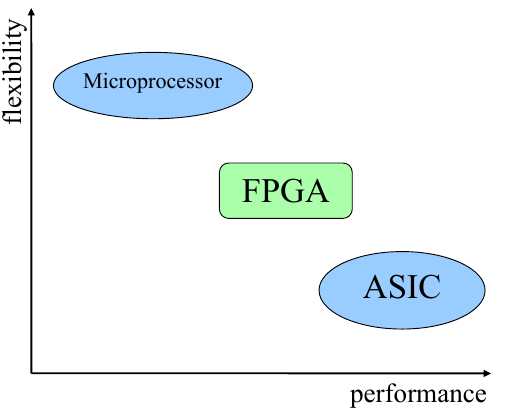
Fig. 1. Trade-off flexibility performance for different